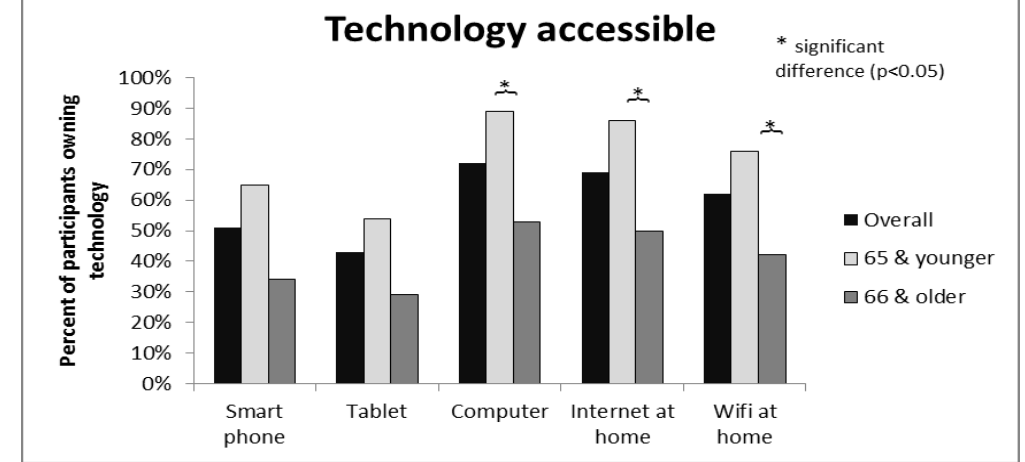
Figure 2. Access to technology in own home of TJR